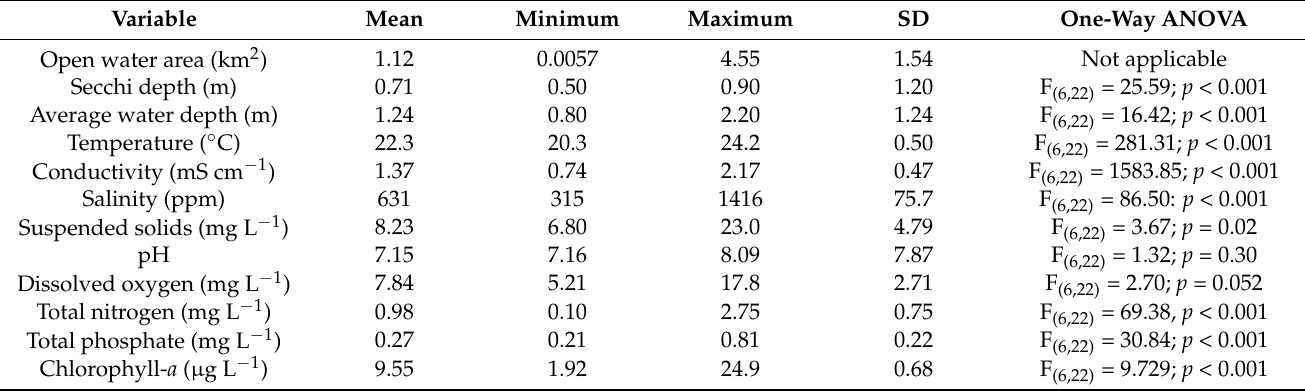
Table 2. Mean, minimum, maximum, and standard deviation (SD) values for physicochemical variables measured in the study lakes (N = 28). Mean values for chemical variables were averaged from three measurements at each study lake. All environmental variables except Secchi depth, pH dissolved oxygen (DO), and total nitrogen (TN) revealed significant spatial variation according to the one-way ANOVA